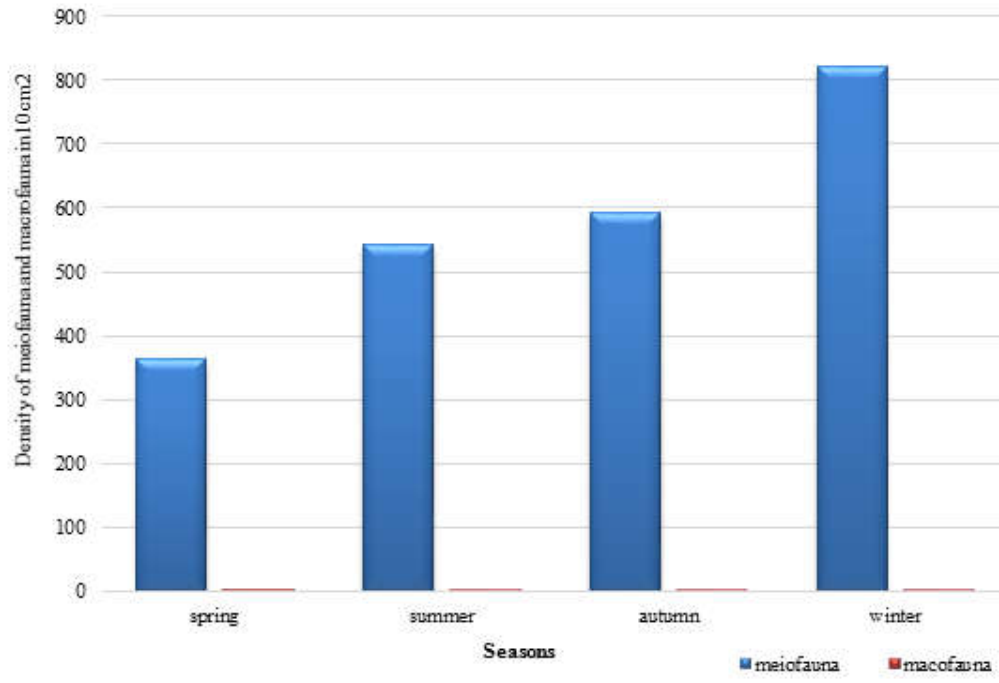
Fig. 4: Density of living benthos in different seasons (in Mazandaran